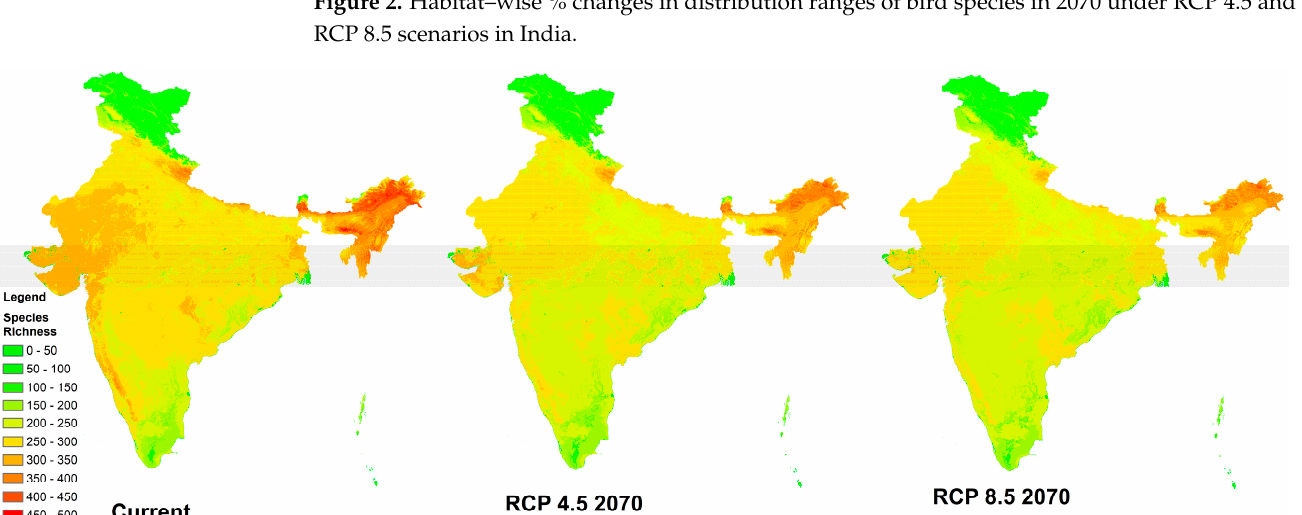
Figure 3. High ‐ resolution maps showcasing bird species richness for the current, RCP 4.5 2070, and RCP 8.5 2070 scenarios in India.